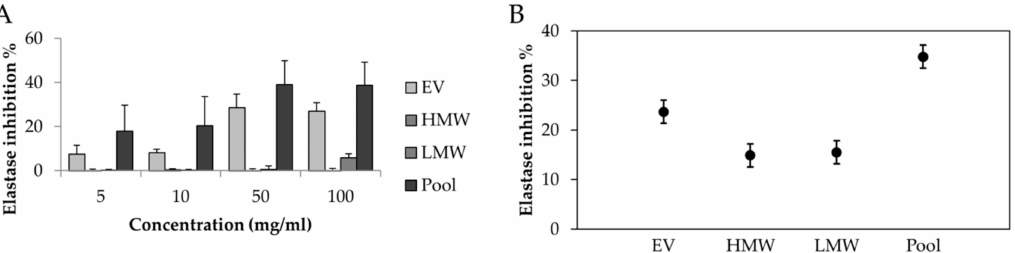
Figure 5. ( A ) Anti-elastase activities of freeze-dried MSC-secretome fractions; mean values ± standard deviation, n = 3. ( B ) Results of average elastase inhibition % as a function of the secretome fraction. Multifactor ANOVA, mean values ± LSD, n =